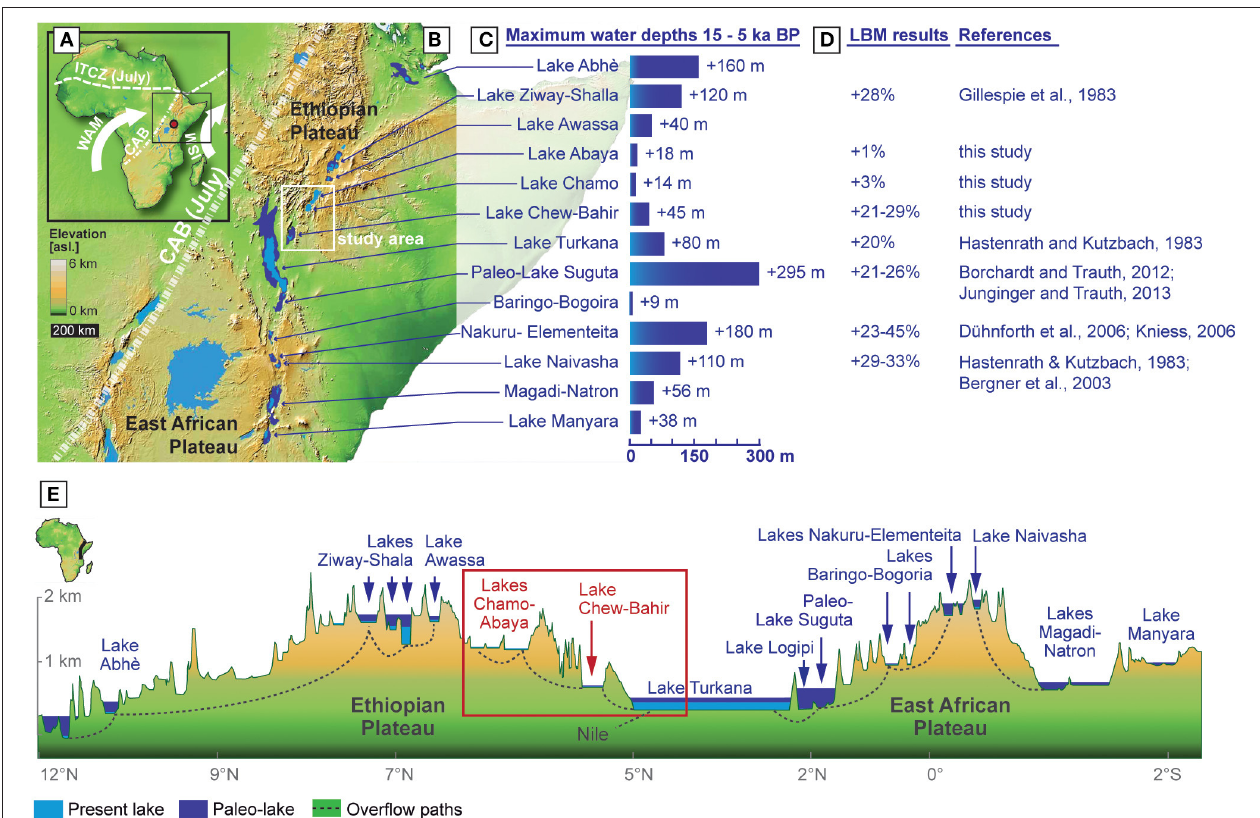
FIGURE 1 | Overview of the study area, lake levels and lake-balance modeling results from previous an current studies: (A) Elevation map of Africa and the positions of major air boundaries and convergence zones during the NH summer. Indian Summer Monsoon (ISM), West African Monsoon (WAM), the Inter Tropical Convergence Zone (ITCZ), and Congo Air Boundary (CAB). (B) Elevation map of eastern Africa with the study area, major lakes, study area (white box) and the CAB position in July. (C,D) Known paleo-lake depths within the EARS during the African Humid Period (AHP) and published paleo-precipitation rates estimates using different lake-balance approaches and associated references. (E) Transect of the EARS from north-east to south, with modern and paleo level lake extents (light and dark blue, respectively), the study area (red box), and major drainage direction (dotted line). North-South transect of the eastern branch of the EARS, with modern and paleo-lake extents (light and dark blue, respectively), the study area (red box), and major drainage direction (dotted line). The figure was modified after Junginger and Trauth (2013).